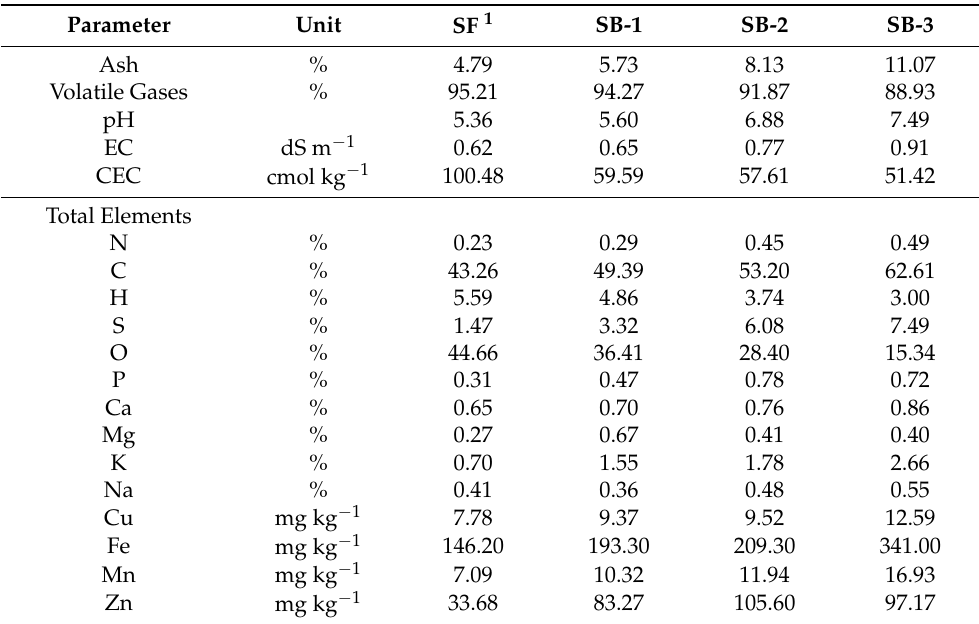
Table 1. The main physicochemical parameters of raw sesame stalk and its biochar produced by different conditions.